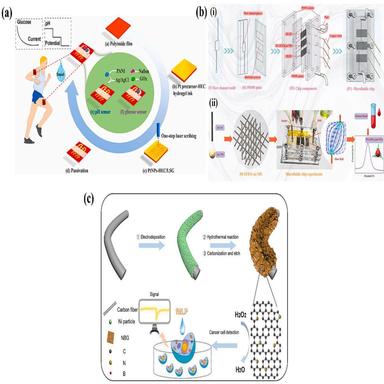
(a) Fabrication of a nanostructured glucose sensing platform comprised of 3D porous laser-scribed graphene (LSG) and platinum nanoparticles (PtNPs). Reproduced with permission. (b) Schematics for (i) manufacturing a microfluidic chip, and (ii) sensor detecting method. Reproduced with permission and (c) Fabrication of CF@3D-NBG flexible microelectrodes for the electrochemical determination of hydrogen peroxide. Reproduced with permission.